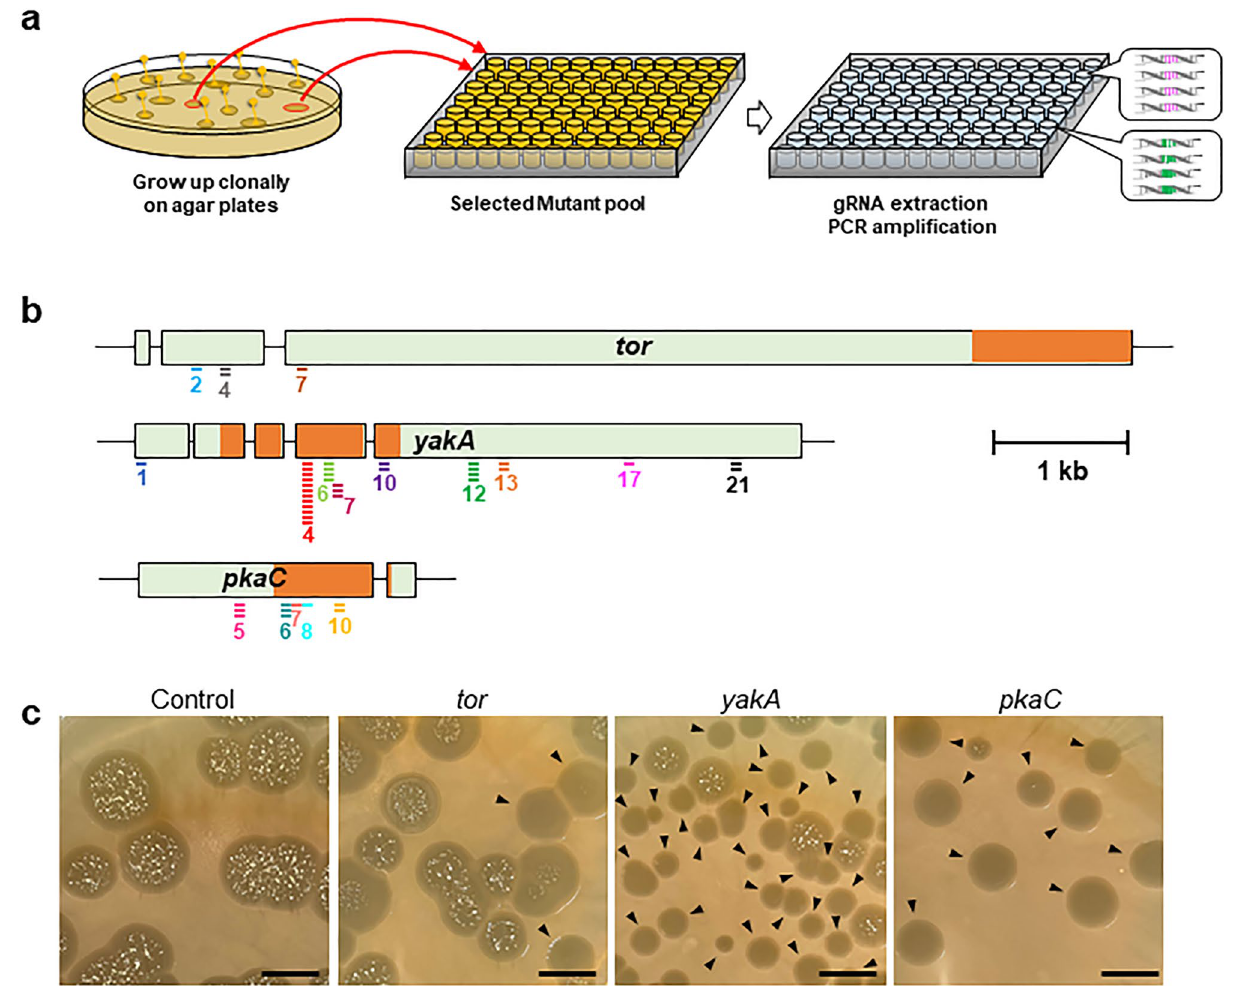
Figure 4. Genetic screening using the CRISPR sgRNA libraries and genetic validation of candidate genes regulating development. ( a ) Schematic overview of genetic screening to identify developmental defective mutants. Mutant pools expressing genome-wide and kinase sgRNA libraries were inoculated on nutrient agar plates with bacteria as a food source and allowed to grow and develop. Isolated plaques exhibiting developmental defects, including aggregation-less and abnormal fruiting bodies, were transferred to 96-well plates. ( b ) Distribution of target sequences detected in developmental mutants. The numbers indicate the serial numbers of gRNAs for each gene and the bars below the gene indicate the frequency of isolation of mutant strains expressing the gRNAs. ( c ) Developmental defects in recreated CRISPR mutants. Aggregation-less mutants are indicated using arrowheads. Scale bars, 1